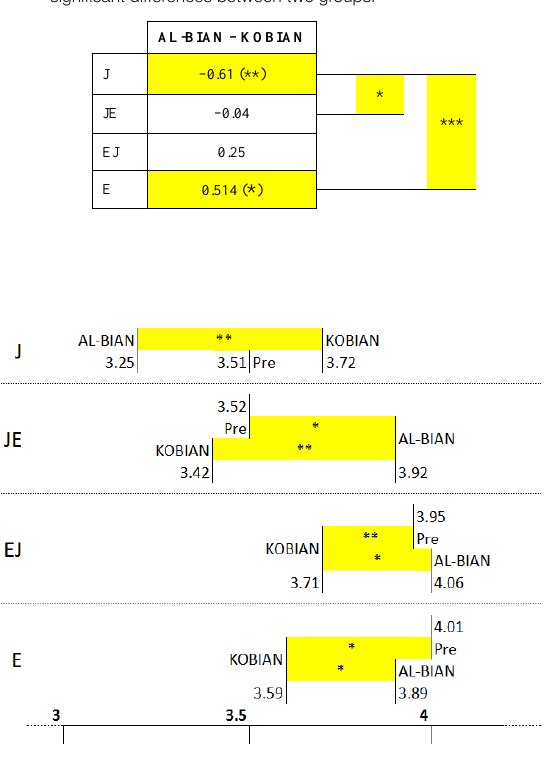
Table 1. Difference in cultural closeness of the two robots for each group and significant differences between two groups.